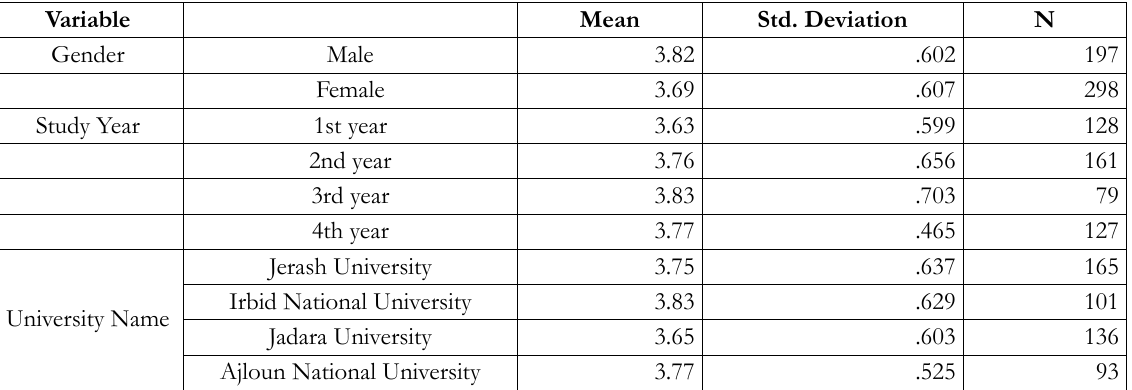
Table 3. Means and standard deviations of the students’ perceptions of flipped classroom in the